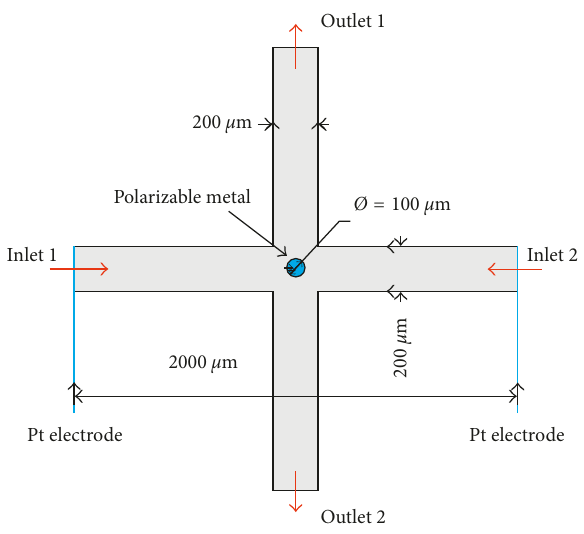
Figure 2: The geometry of micropump.